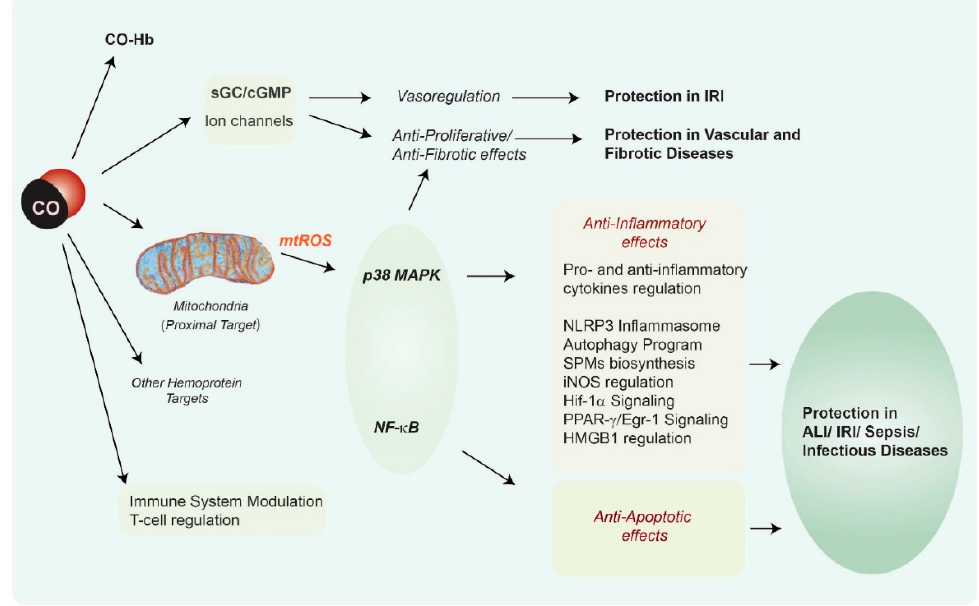
Figure 2. Signaling targets of CO . CO has a high affinity for iron centers and thus can bind and modulate the cellular activity of hemoproteins. CO has been proposed to target sGC, which is a primary receptor of, and has a higher affinity for, nitric oxide [71]. The vasoregulatory effects of exogenous CO, are likely modulated by sGC, with possible contribution from direct ion channel modification [26]. CO has been implicated in several cellular effects, which include the modulation of